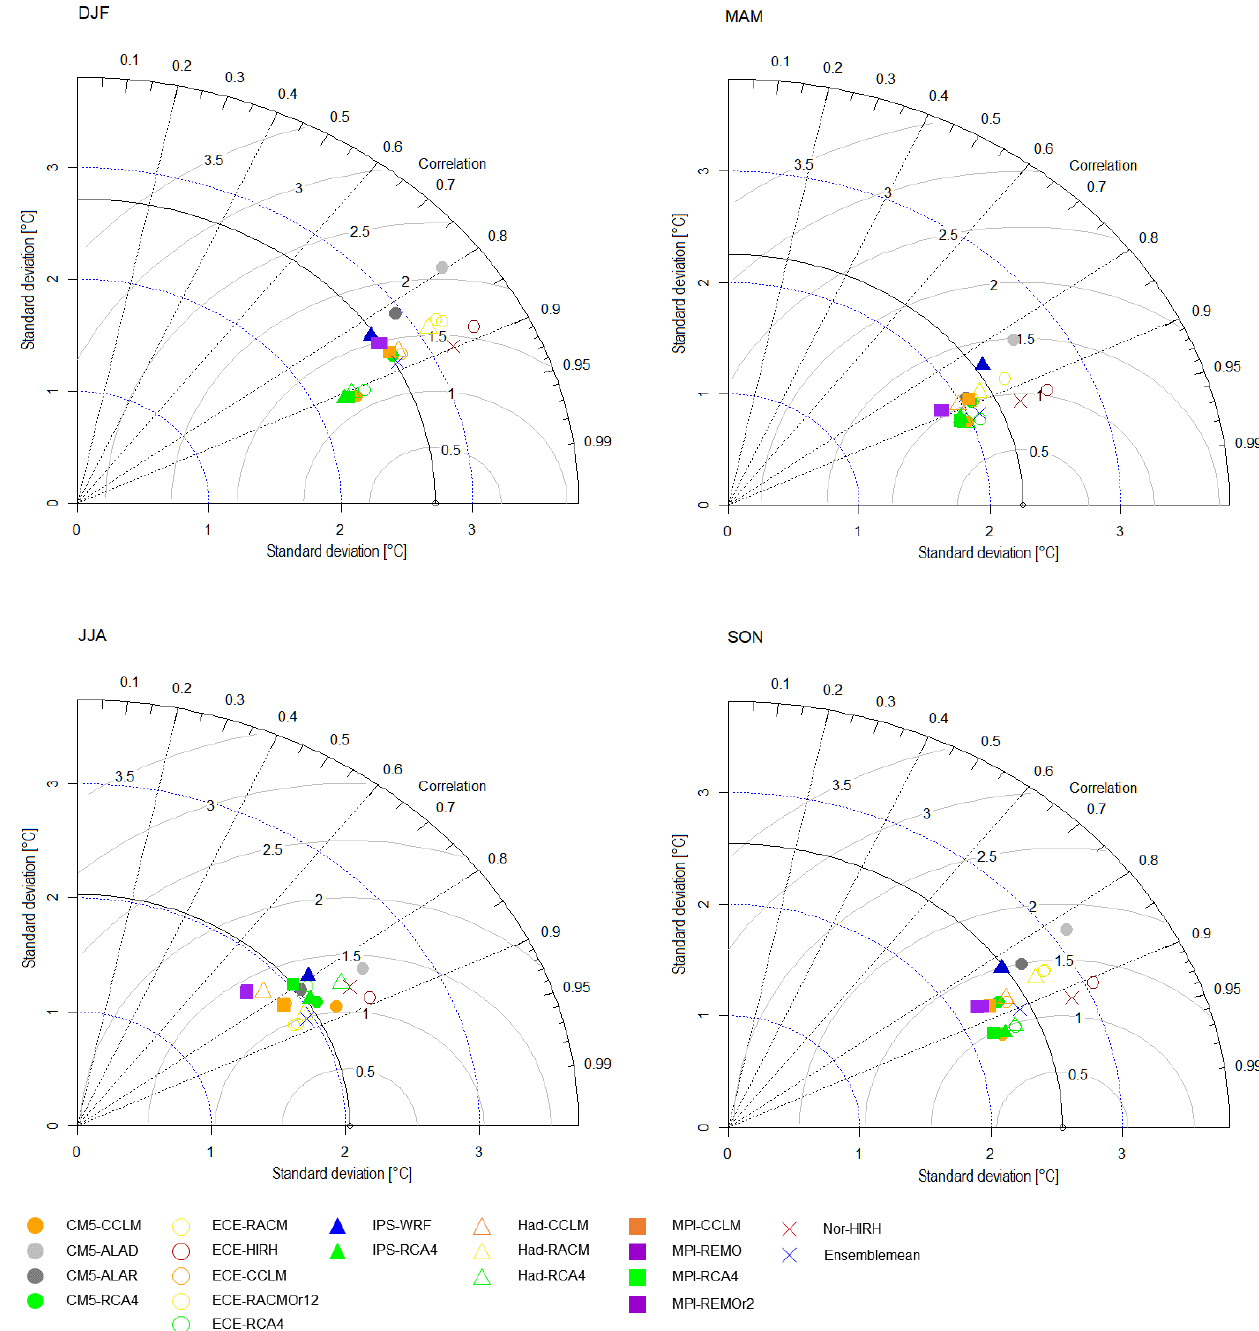
Figure 4. Taylor diagram comparing model performances in reproducing the seasonal variability of mean temperature for the whole study